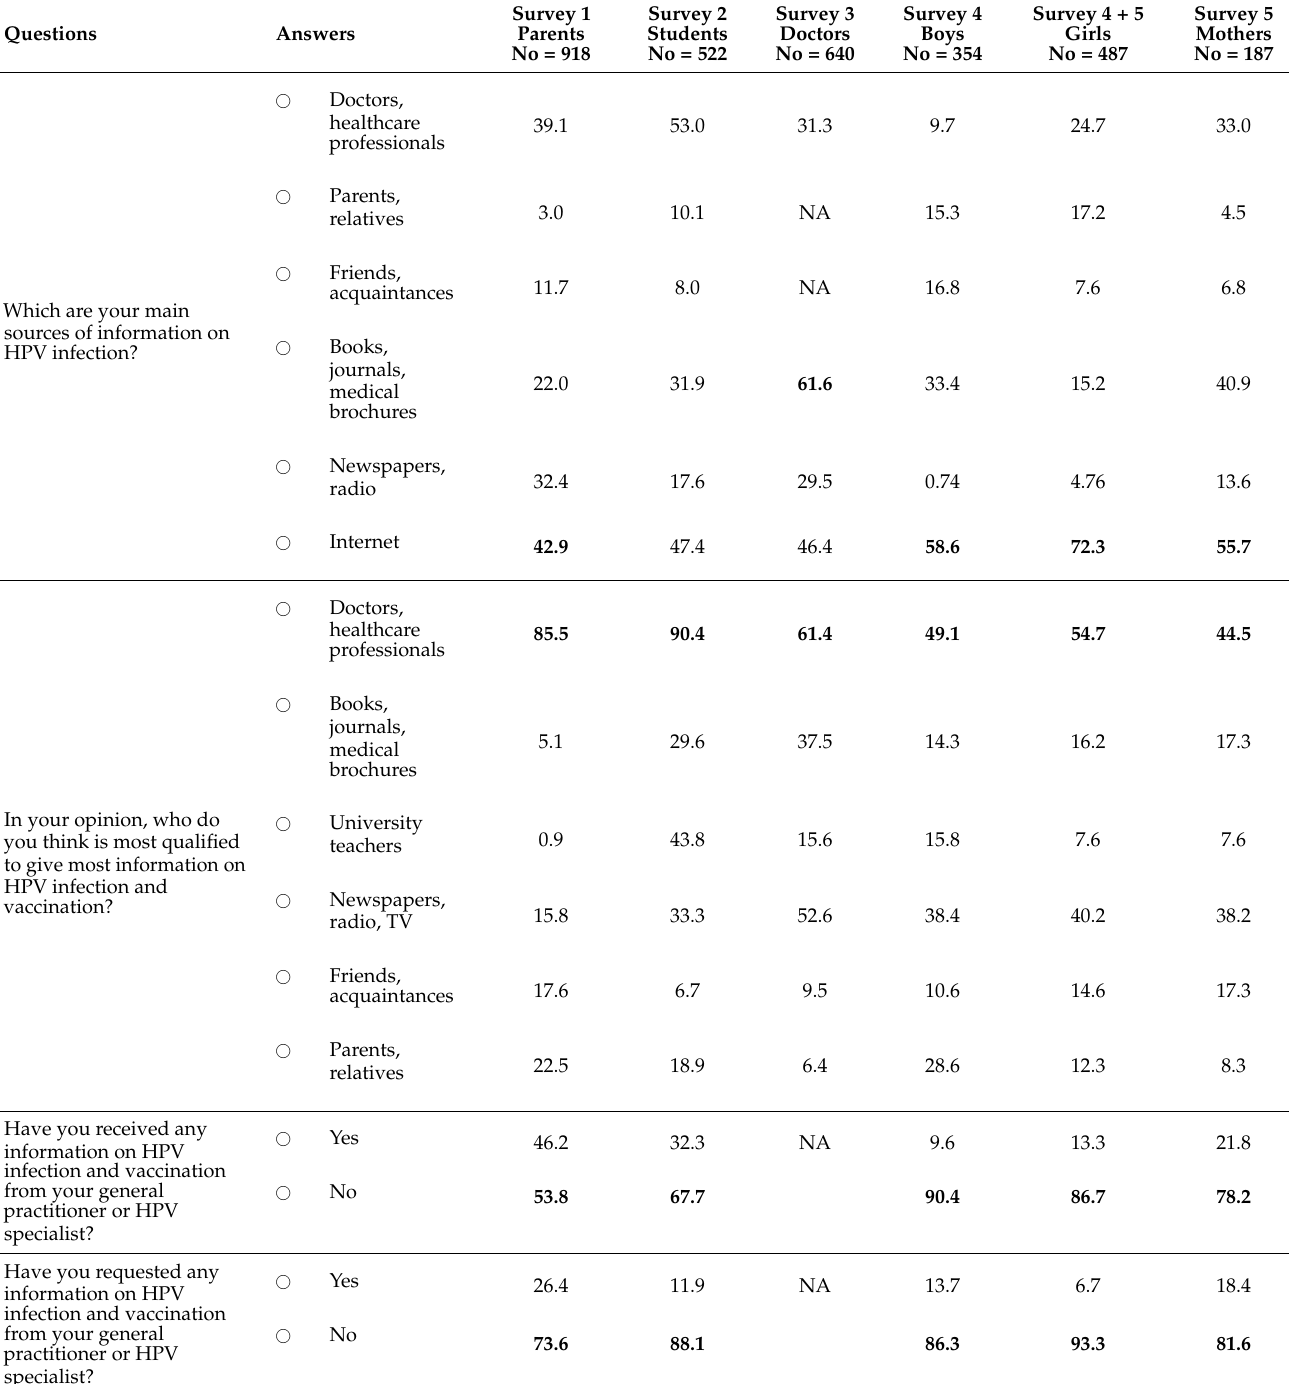
Table 2. Information sources for HPV infection and